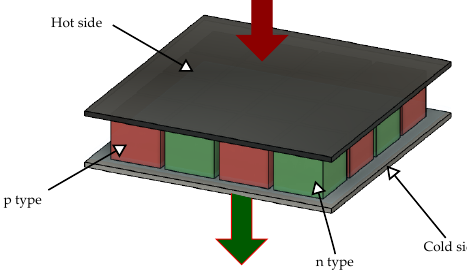
Figure 2. 3D view of a Thermoelectric